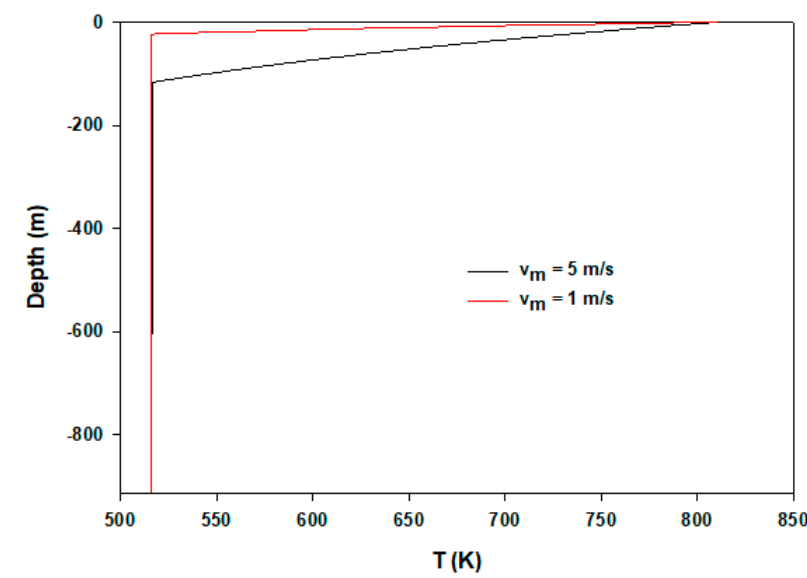
ChemEngineering 2019 , 3 , x FOR PEER REVIEW